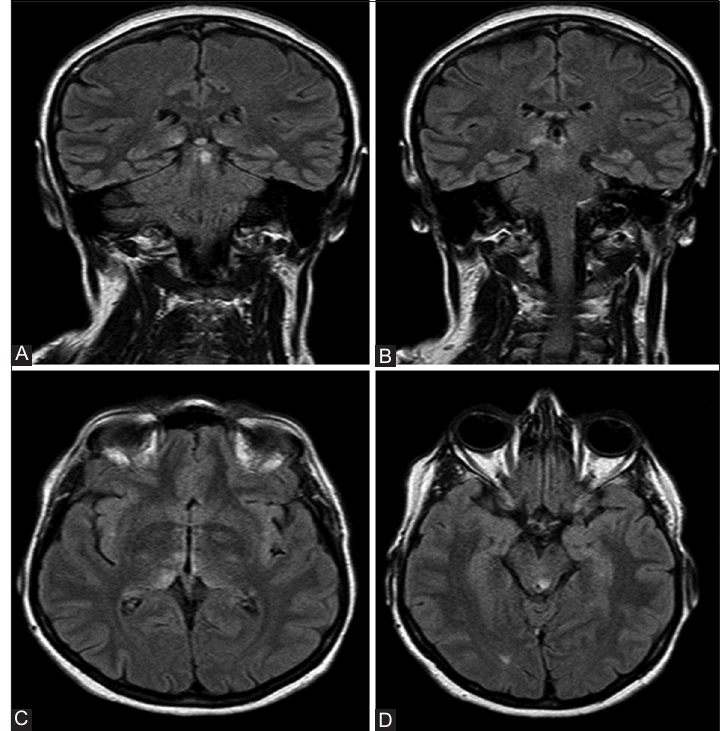
FIGURE 1. Brain magnetic resonance imaging (MRI) showed multiple hyperintense lesions localized in the periaqueductal gray matter (mainly on the left side) and the ventral portion of both the posterior and medial thalami. No restriction of diffusion or pathological enhance- ment after contrast gadolinium was reported. These neuroradiological features were reported as suspicious for a radiological pattern of WE. (A) Coronal T2/fluid attenuated inversion recovery image. (B) Coronal T2/fluid attenuated inversion recovery image. (C) Axial T2/fluid attenuated inversion recovery image. (D) Axial T2/fluid attenuated inversion recovery